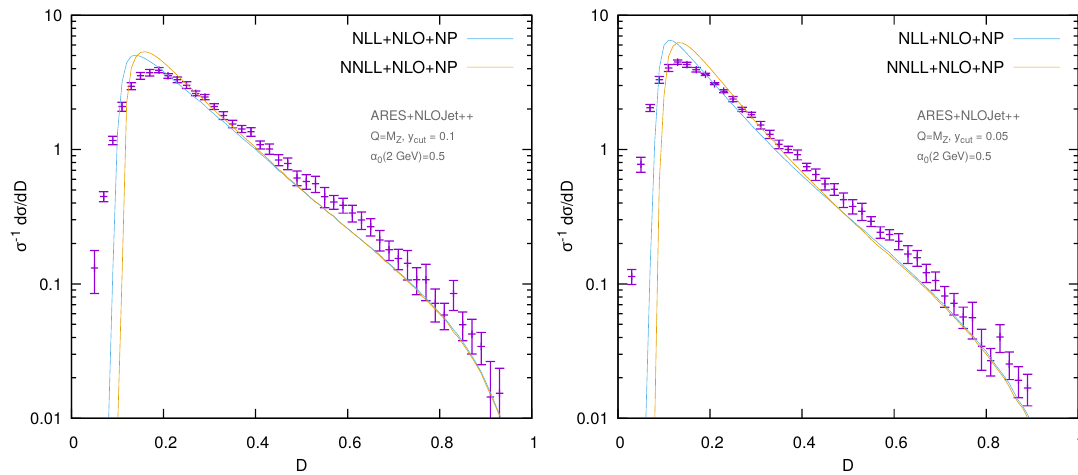
Figure 8 . The matched distribution, including the non-perturbative corrections, is compared to data from LEP1 for the two values of y cut we adopt in this